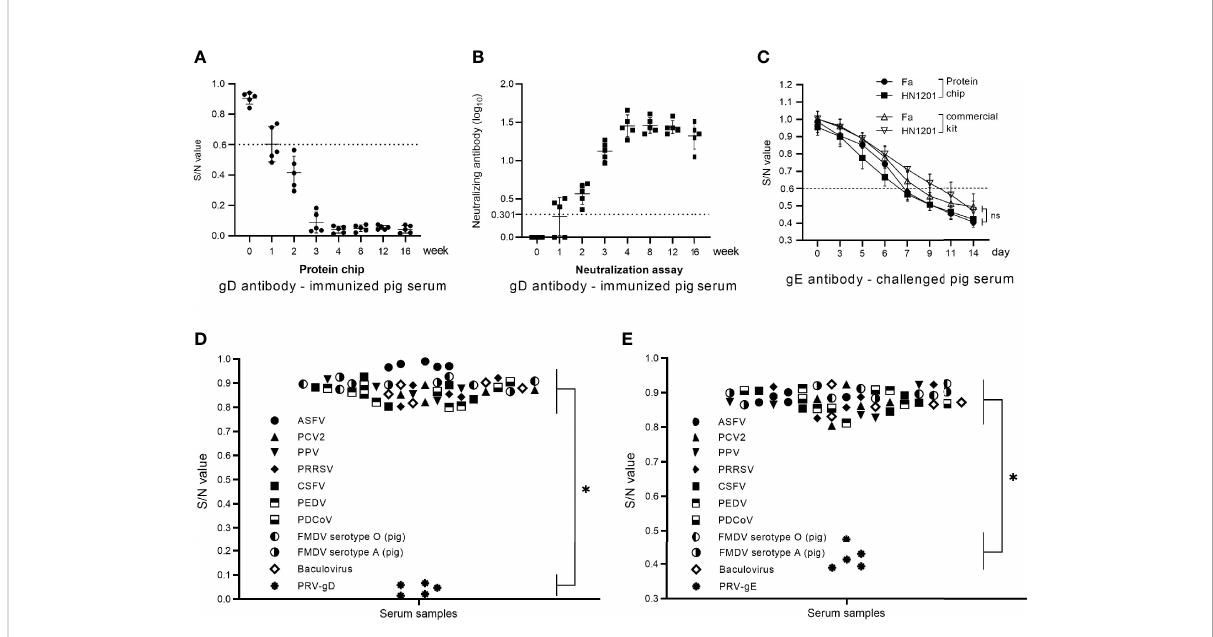
FIGURE 4 Sensitivity and speci fi city evaluation of the chip detection system in gD and gE Abs. (A) The gD Ab of immunized pig serum samples (0 – 16 wpi) tested by the protein chip detection system. (B) The gD Ab of immunized pig serum samples (0 – 16 wpi) tested by neutralization assay. (C) The gE Ab of challenged pig serum samples (0 – 14 dpc) tested by the protein chip detection system and commercial gE Ab kit. (D) Speci fi city assay of the chip detection system in gD Ab detection using the positive serum samples of ASFV, PCV2, PPV, PRRSV, CSFV, PEDV, PDCoV, FMDV serotype O (pig), FMDV serotype A (pig), baculovirus, and PRV-gD (n = 5). (E) Speci fi city assay of the chip detection system in gD Ab detection using the positive serum samples of ASFV, PCV2, PPV, PRRSV, CSFV, PEDV, PDCoV, FMDV serotype O (pig), FMDV serotype A (pig), baculovirus, and PRV-gE (n = 5). S/N value > 0.7 is considered negative. The comparison of chip detection and commercial kit methods was analyzed by one-way ANOVA using GraphPad Prism 8.0. ns, not signi fi cant. * p < 0.05.